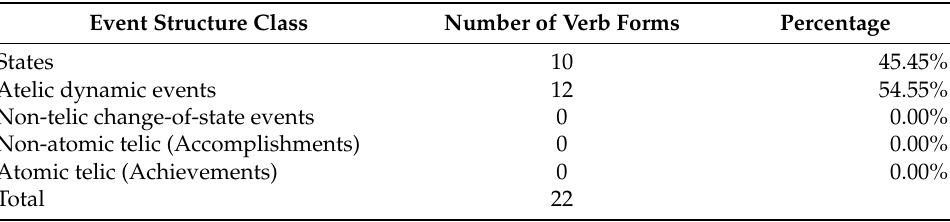
Table 5. Event structure classes in our sub-corpus of non-past (= present)-inflected verbs.